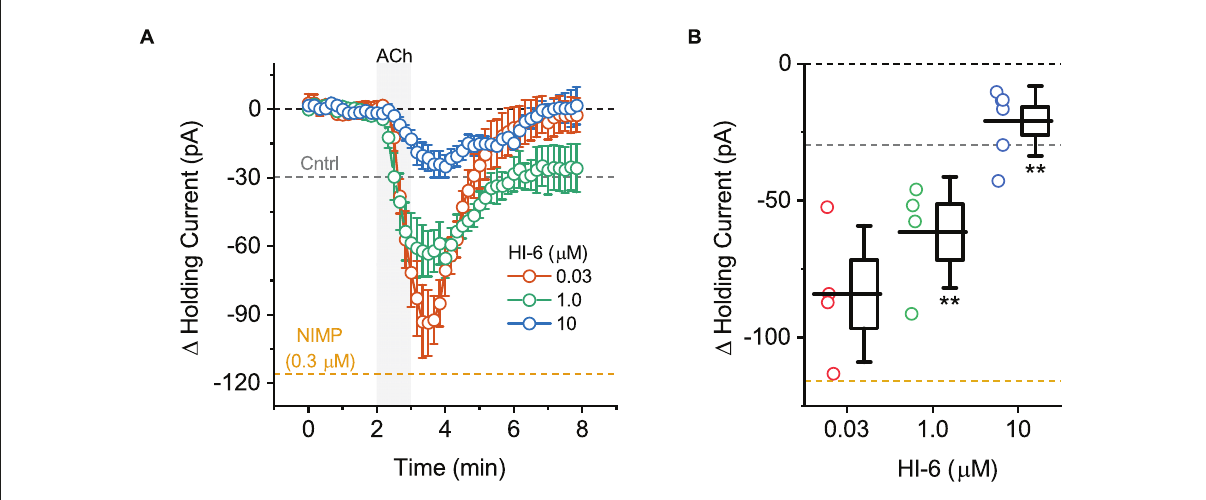
FIGURE3 ACh-induced changes in holding current in BLA pyramidal neurons can be used to quantify the effectiveness of AChE reactivators in slices preincubated with NIMP. (A) ACh-induced change in holding current over time as recorded in BLA pyramidal neurons from slices preincubated in 0.3 µ M NIMP, and then treated with various concentrations of AChE reactivator HI-6 as indicated in the legend. (B) Summary data illustrating the ACh-induced change in holding current, observed from 3 to 4 min as plotted in panel (A) , for each cell tested. Group colors are matched to the panel (A) legend. For each group, box height illustrates the SEM, whiskers illustrate the SD, and horizontal lines highlight the group means. In both panels, the dashed gray and orange lines highlight the mean ACh-induced change in holding current as observed at 3–4 min in BLA pyramidal neurons from control and NIMP datasets as illustrated in Figure 1B . Dashed black line highlights 0 pA. **Indicates p ≤ 0.05 compared to responses observed in slices treated identically with NIMP but not exposed to HI-6. See text of “Results” Section and Table 1 for further details.